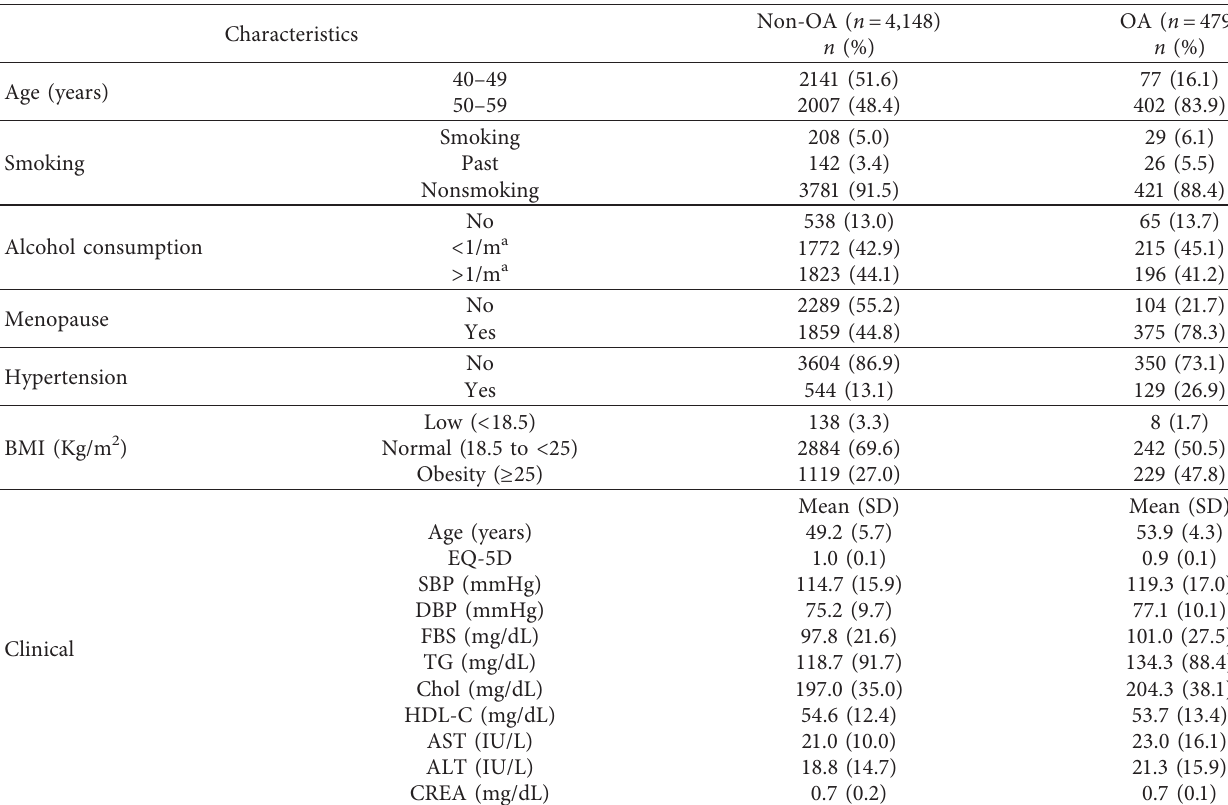
Table 1: Characteristics of the groups with and without